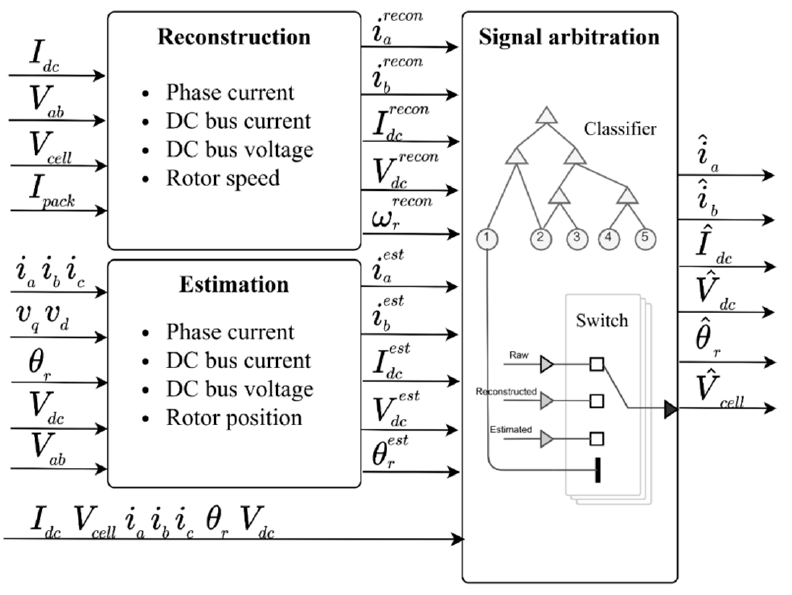
Figure 5. SoP estimation method and its implications.